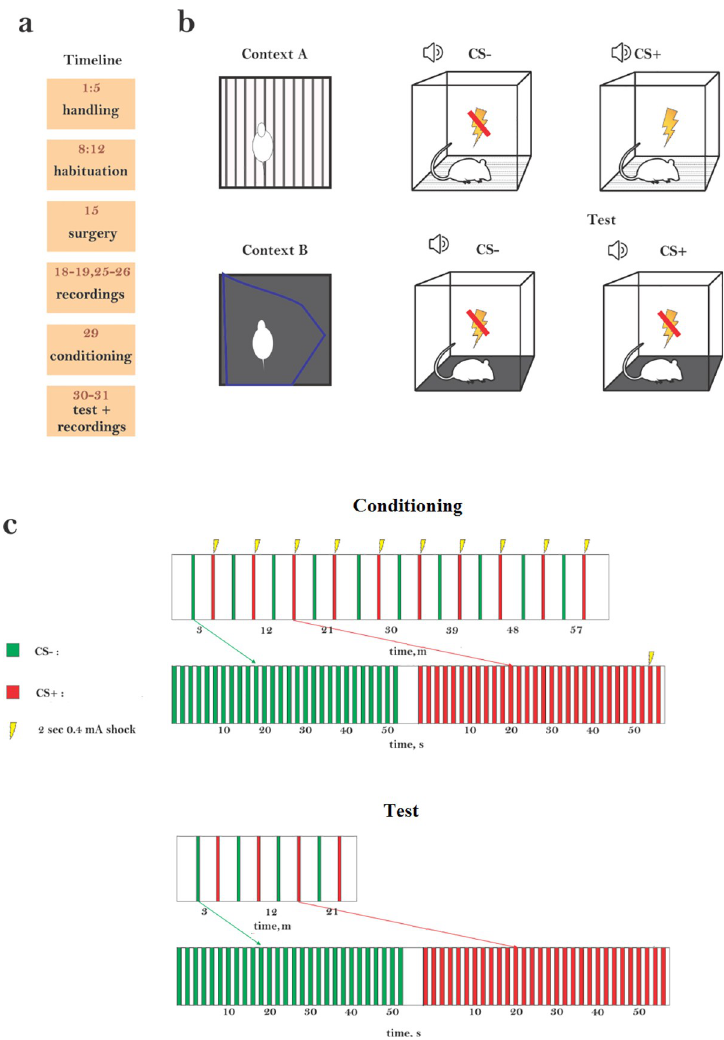
Fig 1. Experimental design. (a) The timeline of the experiment (in days). (b) Conditioning was performed in context A (CS+ coupled with foot shocks), testing was performed in context B (CS+ without foot shocks). (c) To induce conditioning, animals were exposed to 20 blocks of sounds, alternating between CS- (green) and CS+ (red). A block consisted of a 30s train of one of the stimuli delivered at 0.5 Hz. CS+ was paired with a foot shock (2 s, 0.4 mA). The onset of the foot shock was 2 seconds before the end of the sequence. In a fear retrieval test, rats received alternately 4 presentations of CS–and 4 presentations of CS+ stimuli with no shock associated with